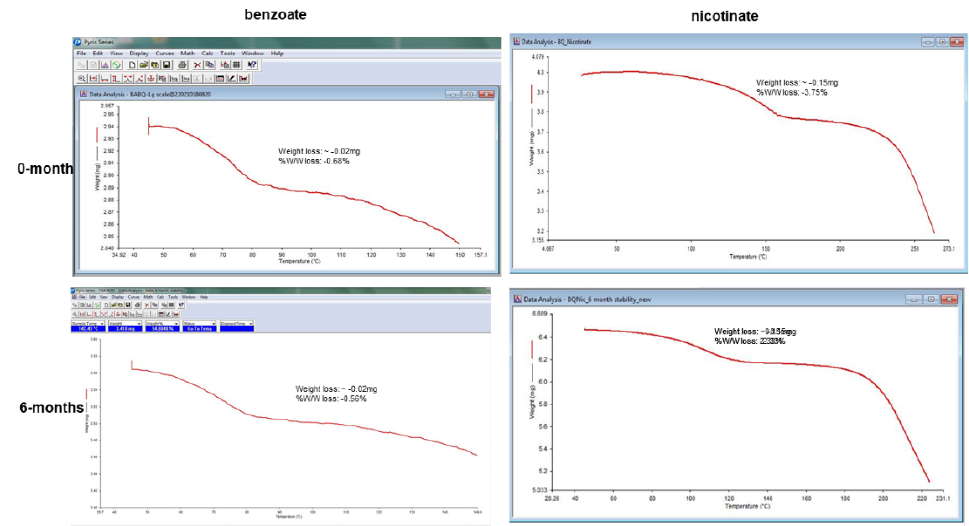
Figure 13. TGA events of dehydration for the initial and 6-month stability samples of benzoate and nicotinate, suggesting that the salts were still hydrated after the stability studies.